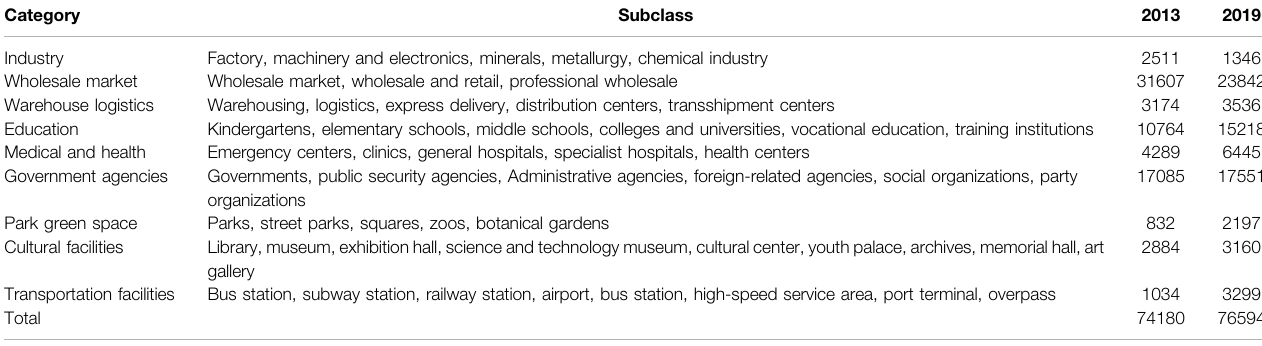
TABLE 1 | POI data collection in 2013 and 2019.